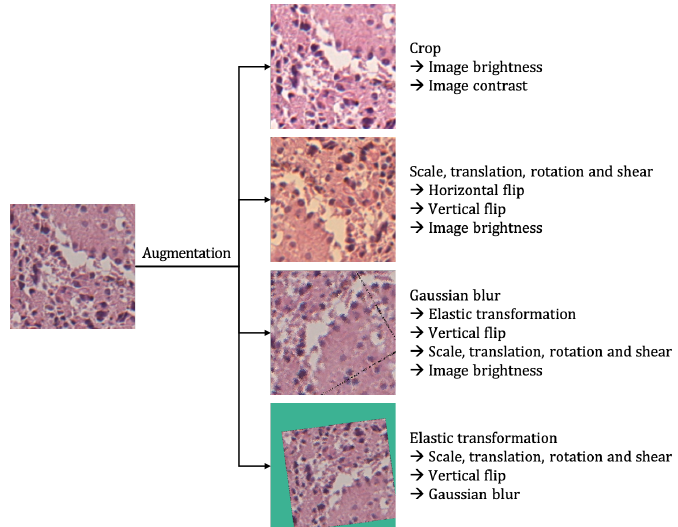
Figure 4. Application of random image augmentation to an image patch. The augmentations applied to the patch are listed on the